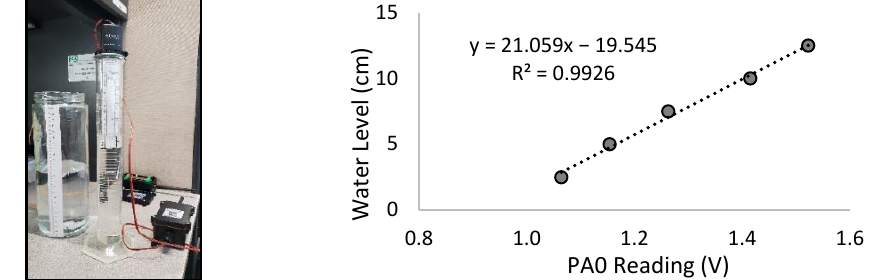
Figure 4. Calibration of the sensor ( left ) and calibration graph ( right ).